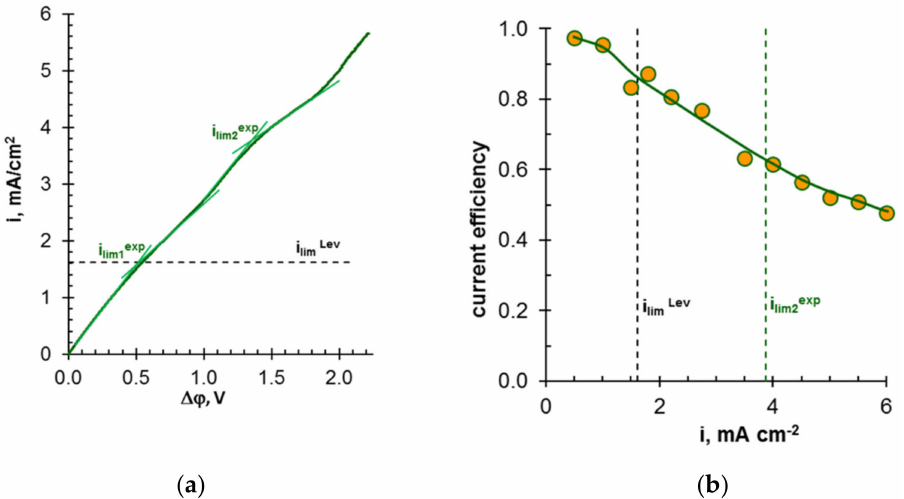
Figure 19. Current-voltage curves ( a ) and dependence of P V current efficiency upon current den- sity ( b ), obtained in the Fujifilm Type X/0.02 M NaH 2 PO 4 solution system (Fujifilm, Netherlands) (pH = 4.6). The dashed lines show the values of the limiting currents calculated by Equations (1)–(3) and found from the experimental current-voltage curve as shown in fragment ( a ). Based on [198].